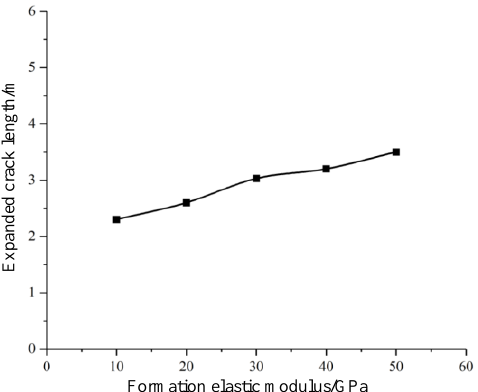
Figure 18. The effect of mechanical parameters of formation on the crack propagation.